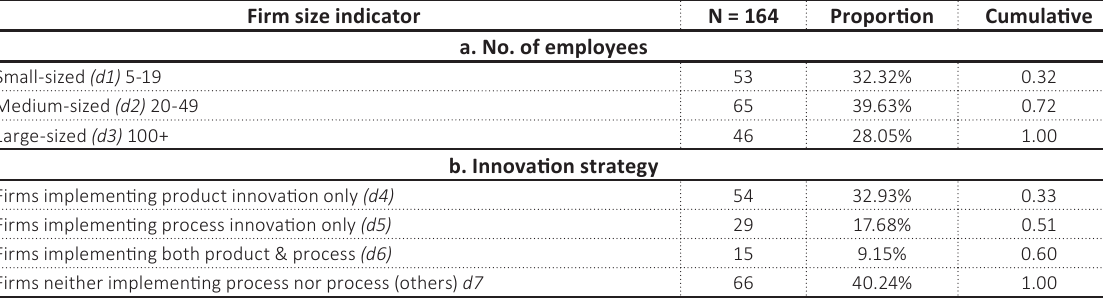
Table 2. Firm distribution by size and innovation